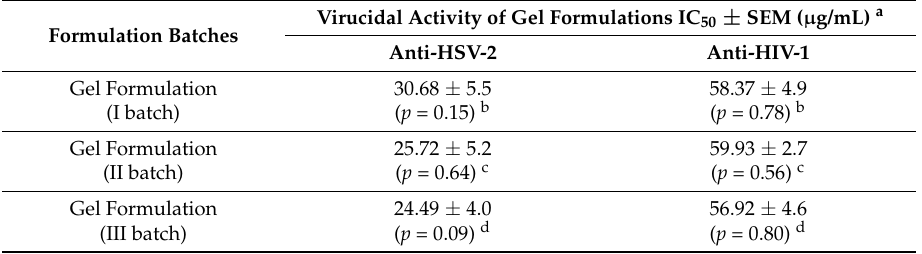
Table 2. Anti HSV-2 and HIV-1 activities of three additional different batches of gel formulation.